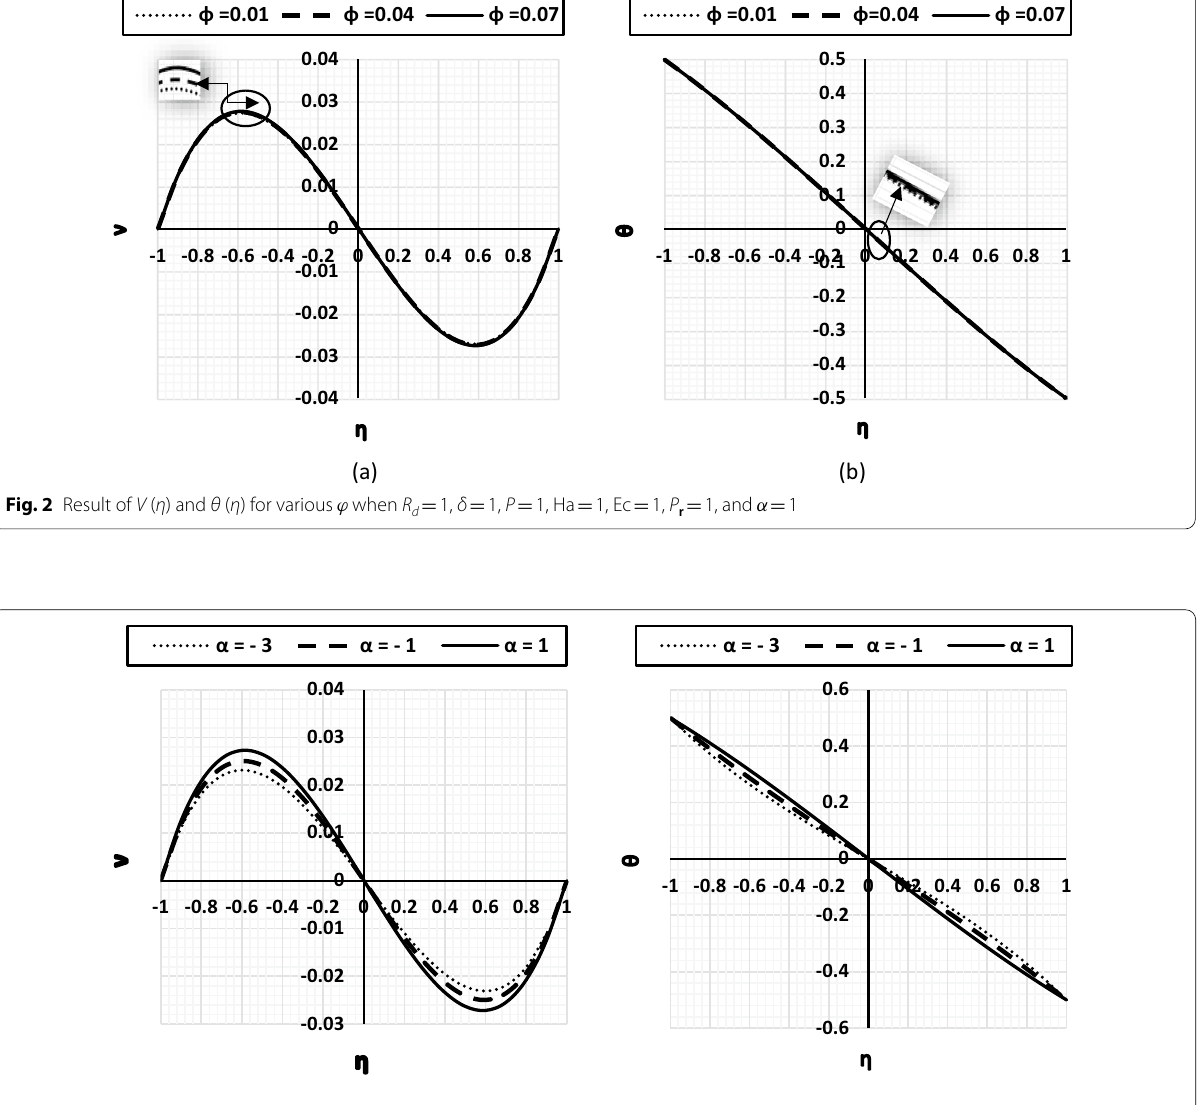
0.01, δ 1, P 1, Ha 1, Ec 1, Pr 1, and R d = = = = = =